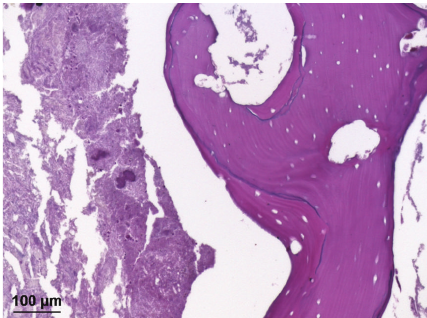
Figure 3: Histopathology of surgical specimen. Note the acellular and avascular osseous tissue with reversal lines and irregular surface. Interspersed between bone tissue fragments there is a slightly basophilic, amorphous, and acellular material, suggestive of microbial colonies (hematoxylin and eosin; original magnification × 200).